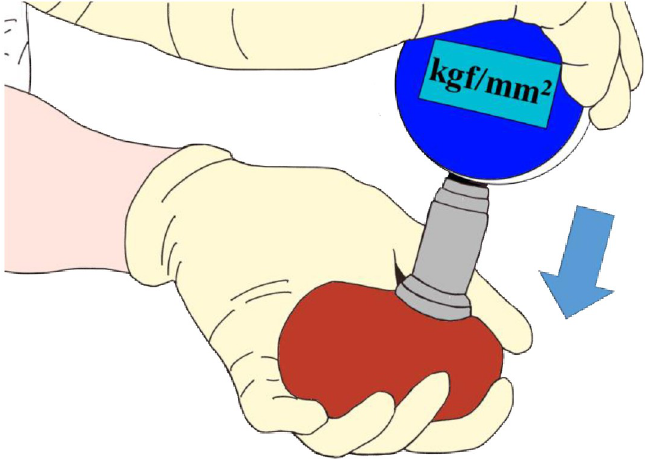
Fig 2. Hardness evaluation. A view of a hardness meter being pressed against the center of the